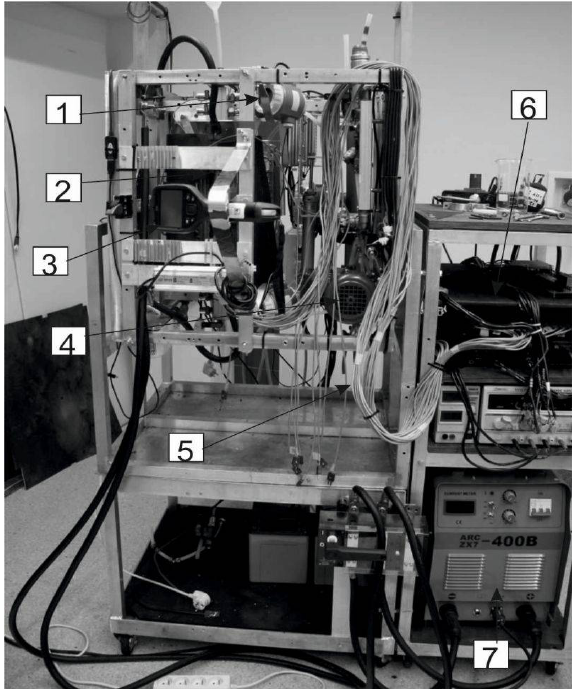
Fig. 1. A view of the main systems of the experimental setup: 1 - a pressure meter, 2 - a test section; 3 - an infrared camera, 4 - a gear pump, 5 - a thermocouples, 6 - a data acquisition station, 7 - an inverter welder.